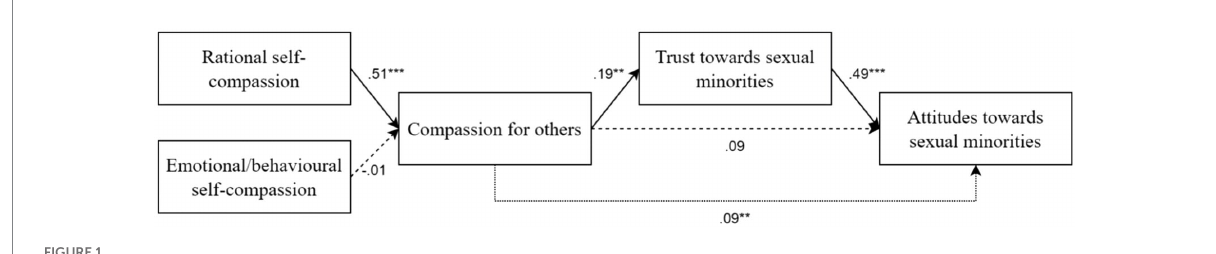
FIGURE 1 Path model with standardized path coefficients. For purposes of readability, error variances are omitted. Dashed lines represent non-significant paths, dotted lines represent indirect effects. ** p < 0.01, *** p < 0.001.